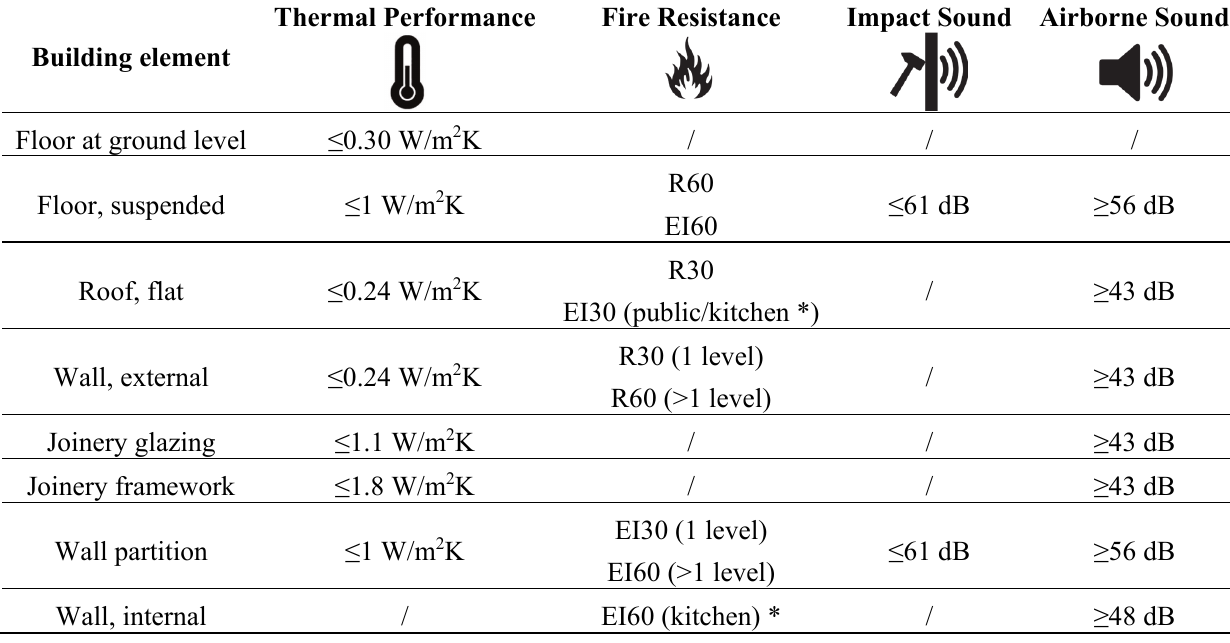
Table 3. To develop different strategies, a summary of the requirements and standards has been made for each element. This guaranties that we will compare equivalent functional